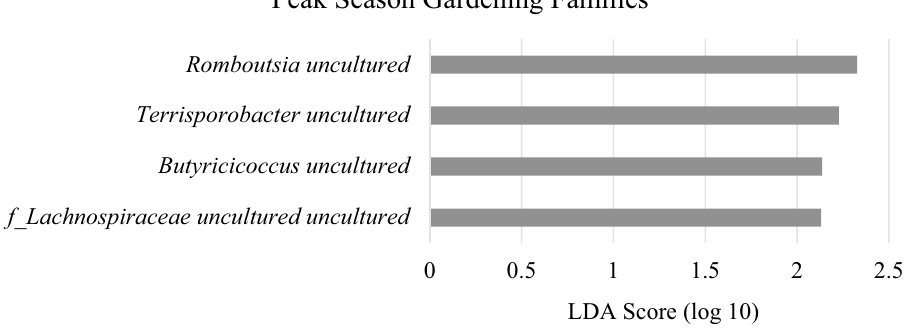
Figure 4. LEfSe analysis of species level in gardening families before the garden season and at peak garden season. Species shown are significantly greater at peak gardening season than before the garden